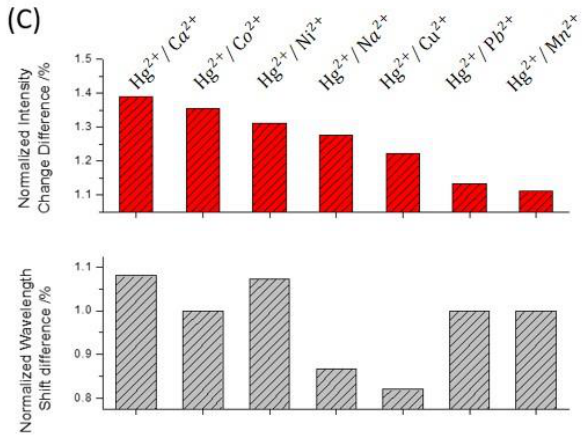
Figure 7. The selectivity of EC-SPR sensors by investigating ( a ) the transmission intensity changes and ( b ) the wavelength shifts for 10 µ M Hg 2+ in the presence of 10 µ M interfering ions in 10 mM KCl solution, including Ca 2+ , Co 2+ , Ni 2+ , Na + , Cu 2+ , Pb 2+ and Mn 2+ . ( c ) The variations of the normalized transmission intensity changes and the wavelength shifts of mixing ions compared to Hg 2+ at 20 min reaction time. The error bars represent the standard deviation from three repeated